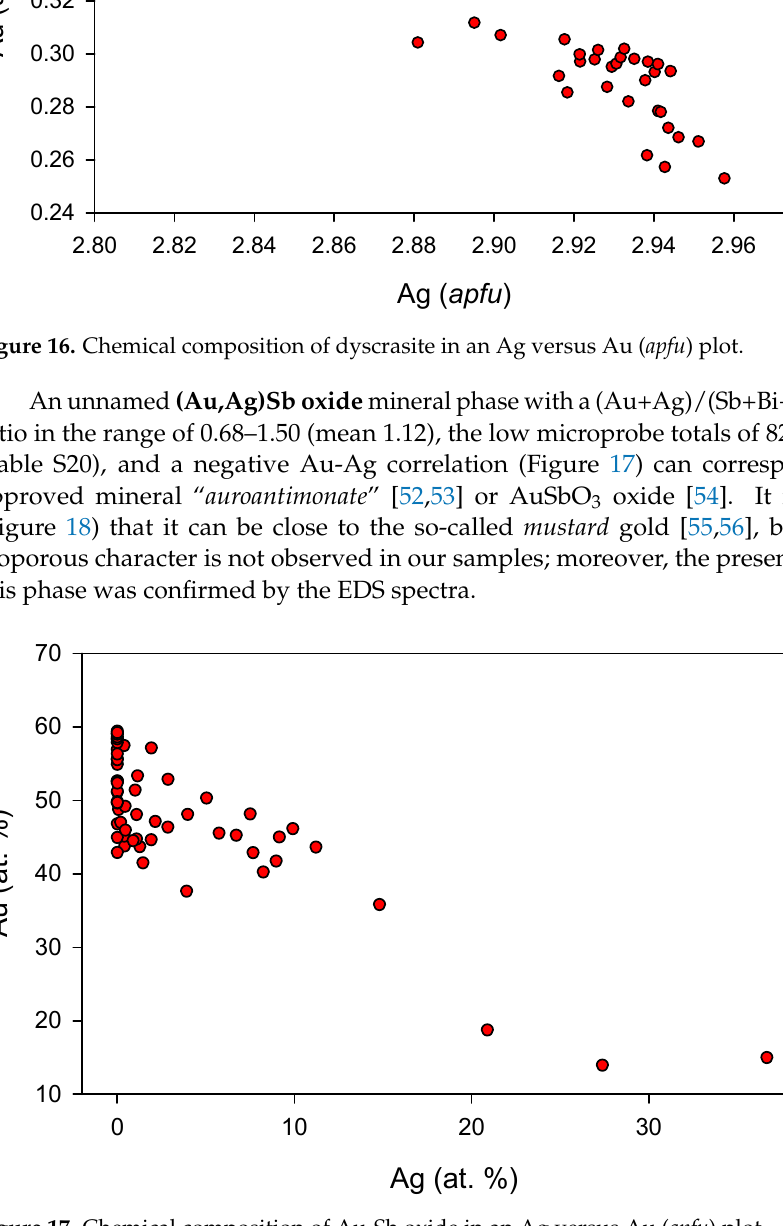
Figure 17. Chemical composition of Au-Sb oxide in an Ag versus Au ( apfu ) plot.